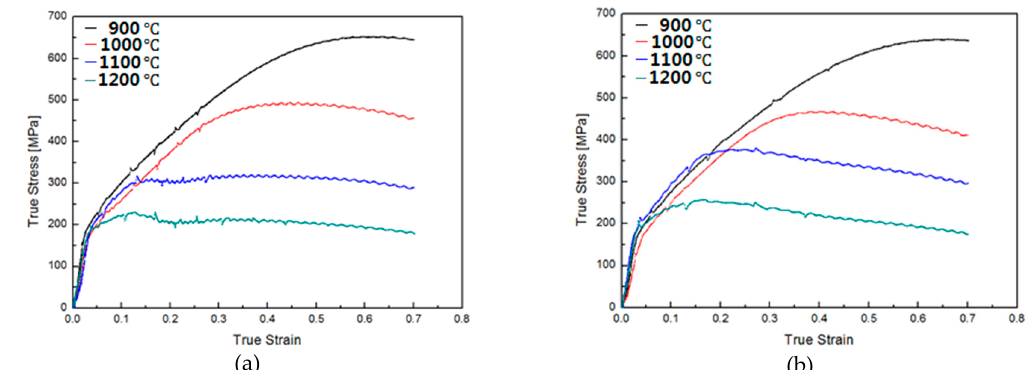
Figure 1. True stress-true strain curves of the compression tests at different temperatures and strain rates: ( a ) strain rate 10 s − 1 , ( b ) strain rate 30 s − 1.